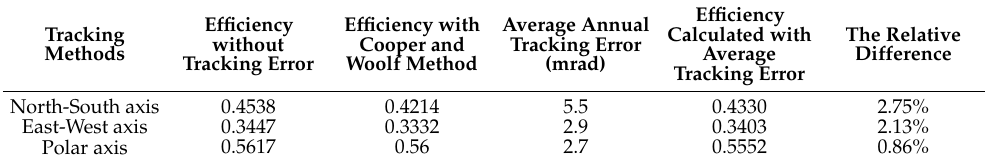
Table 4. Average annual tracking error and efficiency of system with the Cooper and Woolf method under three different tracking methods, efficiency calculated with average tracking error and the relative difference between two